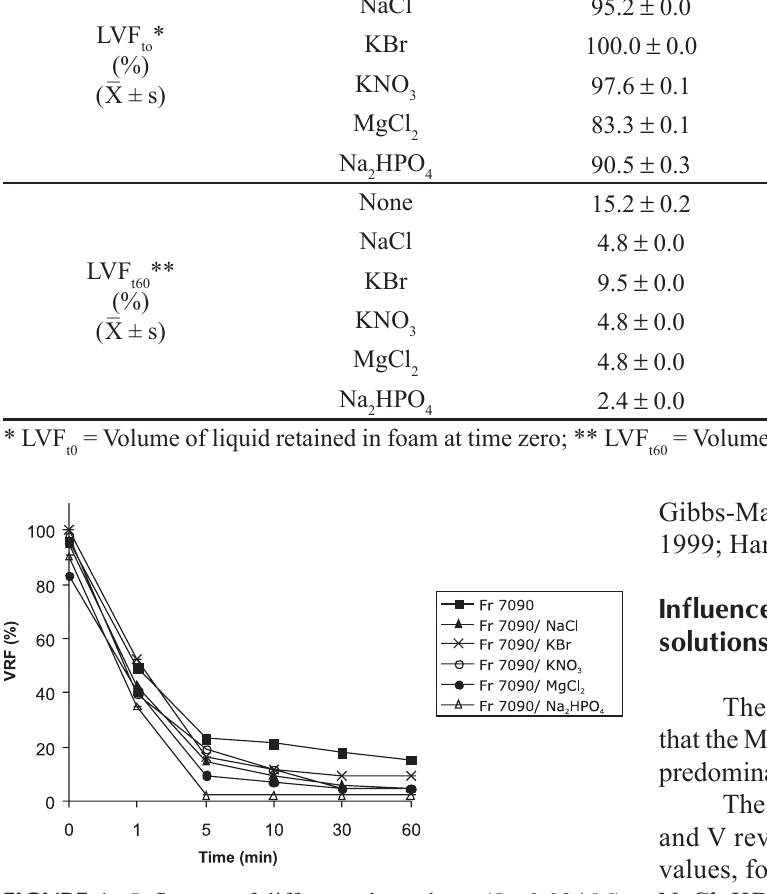
FIGURE 1 - Influence of different electrolytes ( I = 0.024 M) on liquid drainage rate of mate saponin fraction (MSF) foams.